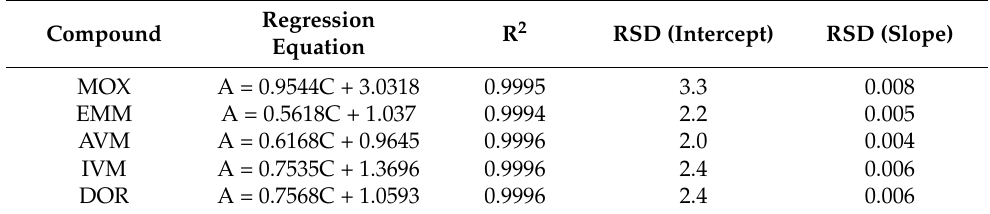
Table 3. Regression equations and correlation coefficients of five AVMs in matrix matching standard solutions.